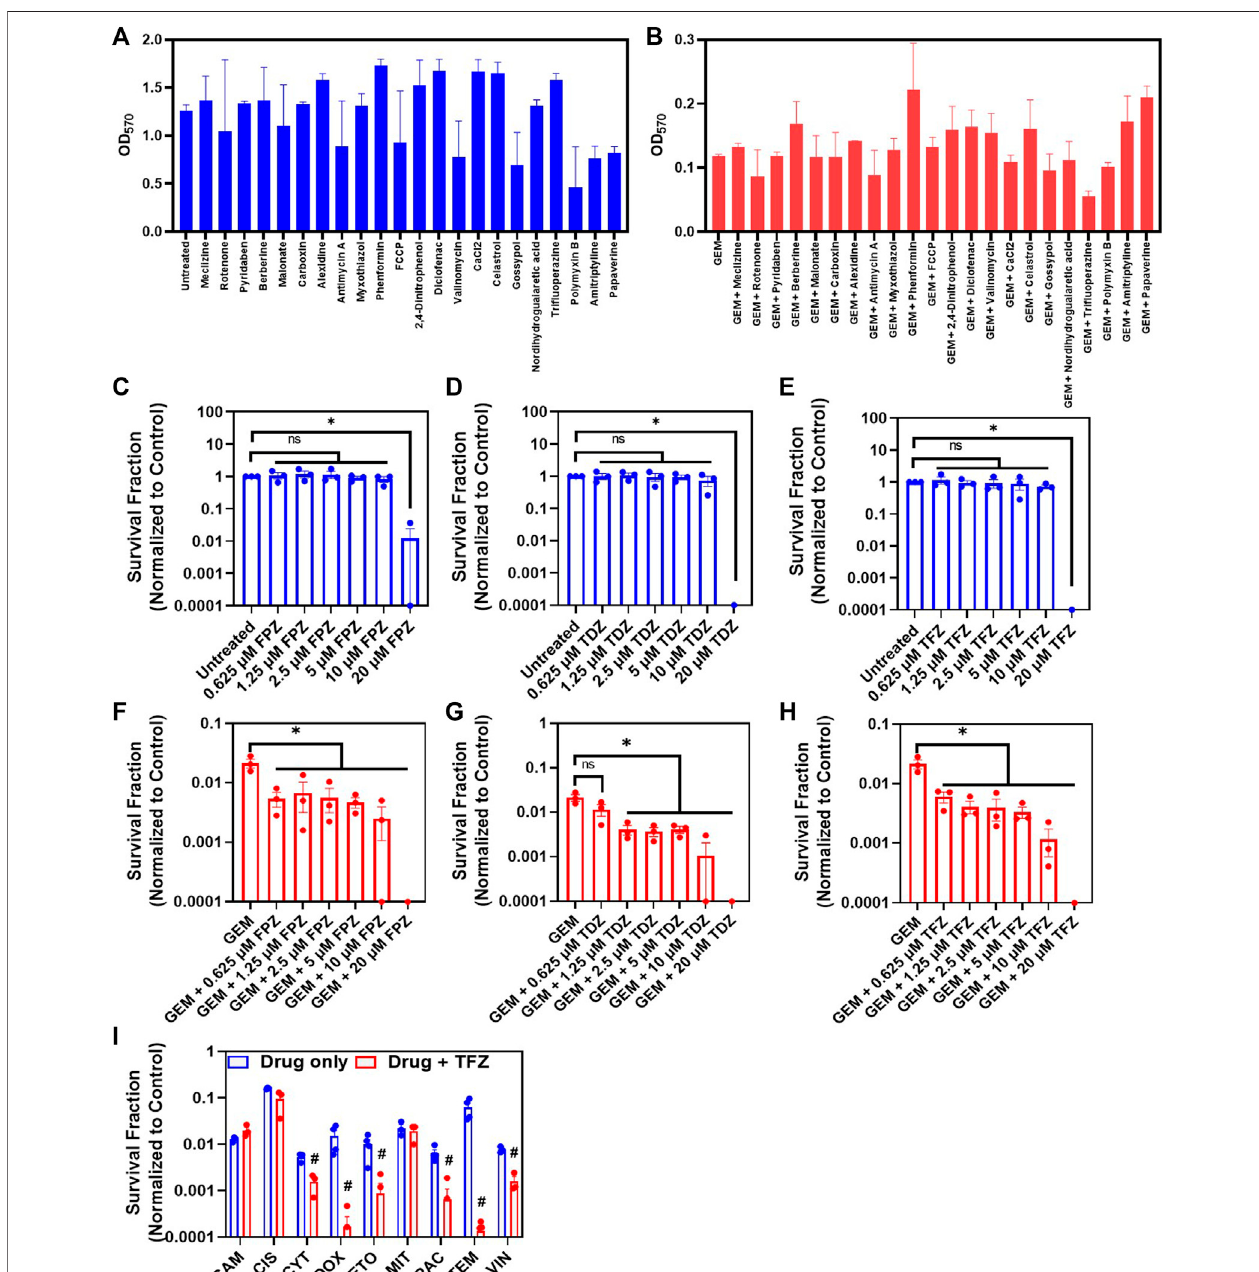
FIGURE5| CotreatmentwithETCinhibitorsreducespersistersurvival: (A) MelanomaA375cellsincubatedinfreshgrowthmediumina96-wellplatefor24 hwere treated with indicated ETC inhibitors (blue) or (B) cotreated with GEM (10x MIC) and ETC inhibitors (red) for 3 days. After the treatment, the media in the wells were replaced with fresh, drug-free media. After 24 h of incubation, the MTT assay was conducted to assess cell viability by measuring the absorbance (OD 570 ) of all tested combinations witha plate reader. N (cid:1) 2. (C – E) Melanoma cells were treated with phenothiazine drugs (TFZ, TDZ and FPZ) or (F – H) co-treated with GEM (10xMIC) andphenothiazinesattheindicatedconcentrationsfor3 days.Afterthetreatments,thecellswereresuspendedinfreshdrug-freemediumandincubatedfor24 h.Then, the cell viability was assessed by trypan blue staining using an automated cell counter. * represents a signi fi cant difference between the control and treatment groups ( t -test, p < 0.05). (I) Melanoma cells were treated with the indicated chemotherapeutic agents and/or TFZ (10 µM) for 3 days. The concentrations of chemotherapeutic agents were 10xIC 50 , except TEM, whose concentration was 5xIC 50 ( Supplementary Table S2 ). After the treatments, the cells were collected and incubated in fresh, drug-free medium for 24 h, and then, the cell viability was assessed with STYO60 (red)/SYTOX (green) dyes using a fl ow cytometer, as the number of surviving cells